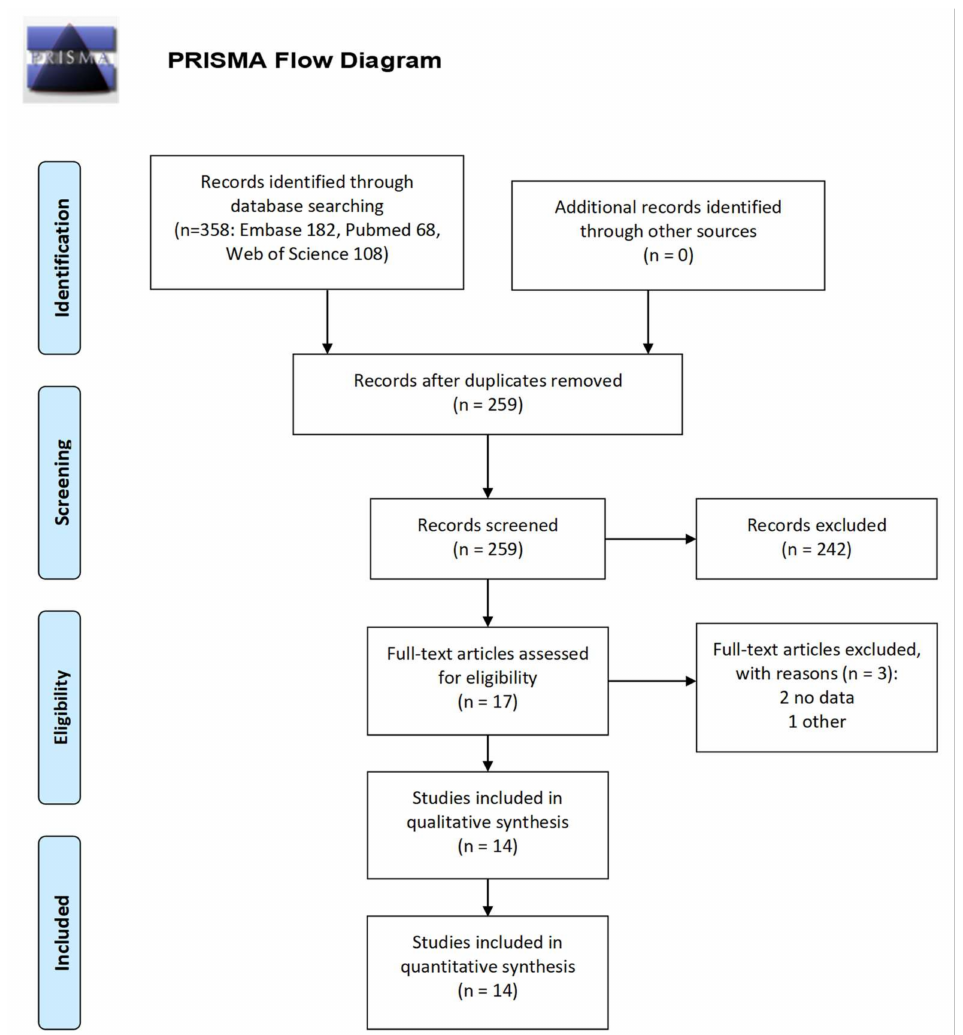
Figure A1. PRISMA flow